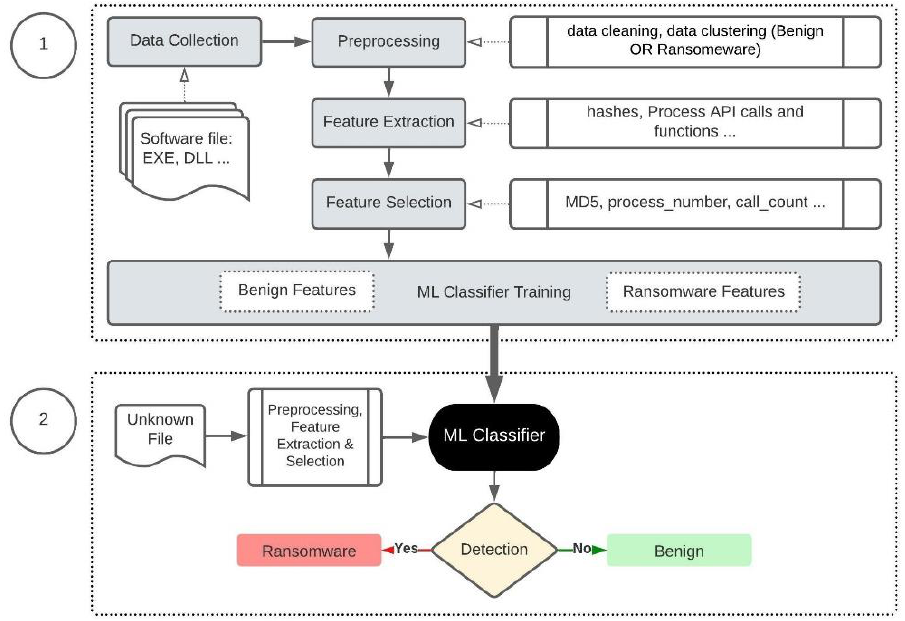
Figure 1. A ransomware detection strategy using Machine Learning. Step 1 demonstrates how a ML classifier is trained, and Step 2 demonstrates how an unknown file is then classified as benign or ransomware using the ML classifier.